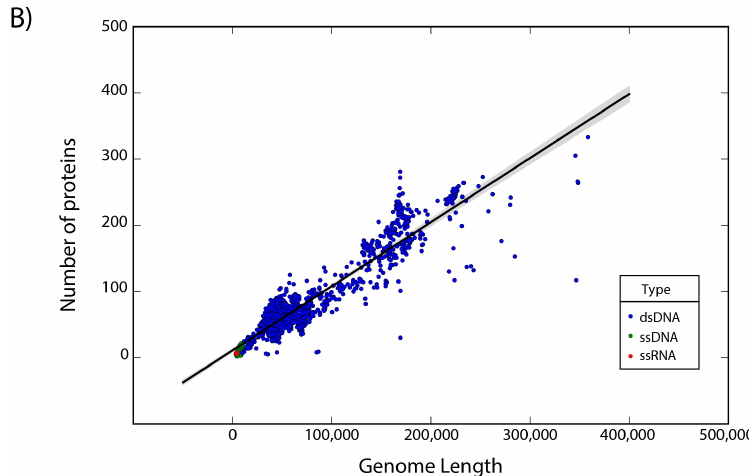
Figure 2. Gene density. Scatter plot showing the gene density of ( A ) eukaryotic viruses and ( B ) phages. Viruses are colored by the type of genetic material and each dot represents a genome. Best-fit lines with 95% confidence intervals from linear regression are